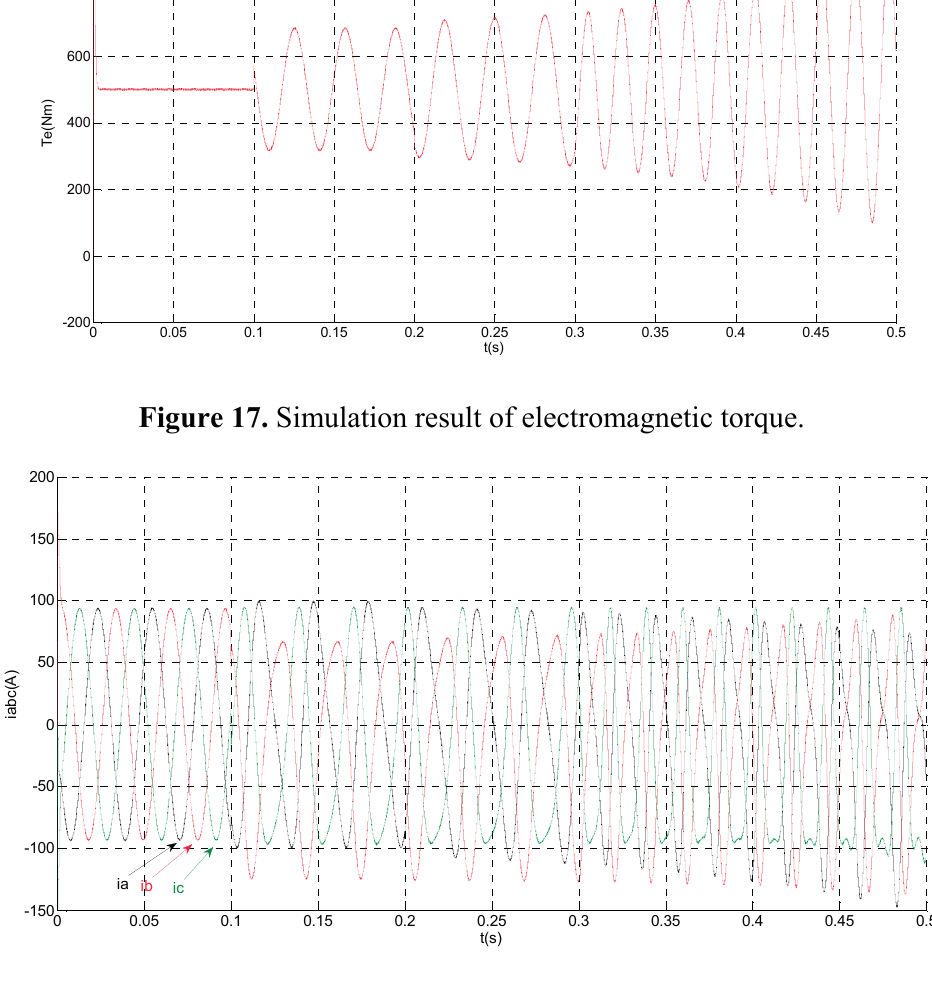
Figure 18. Simulation results of measured phase currents.